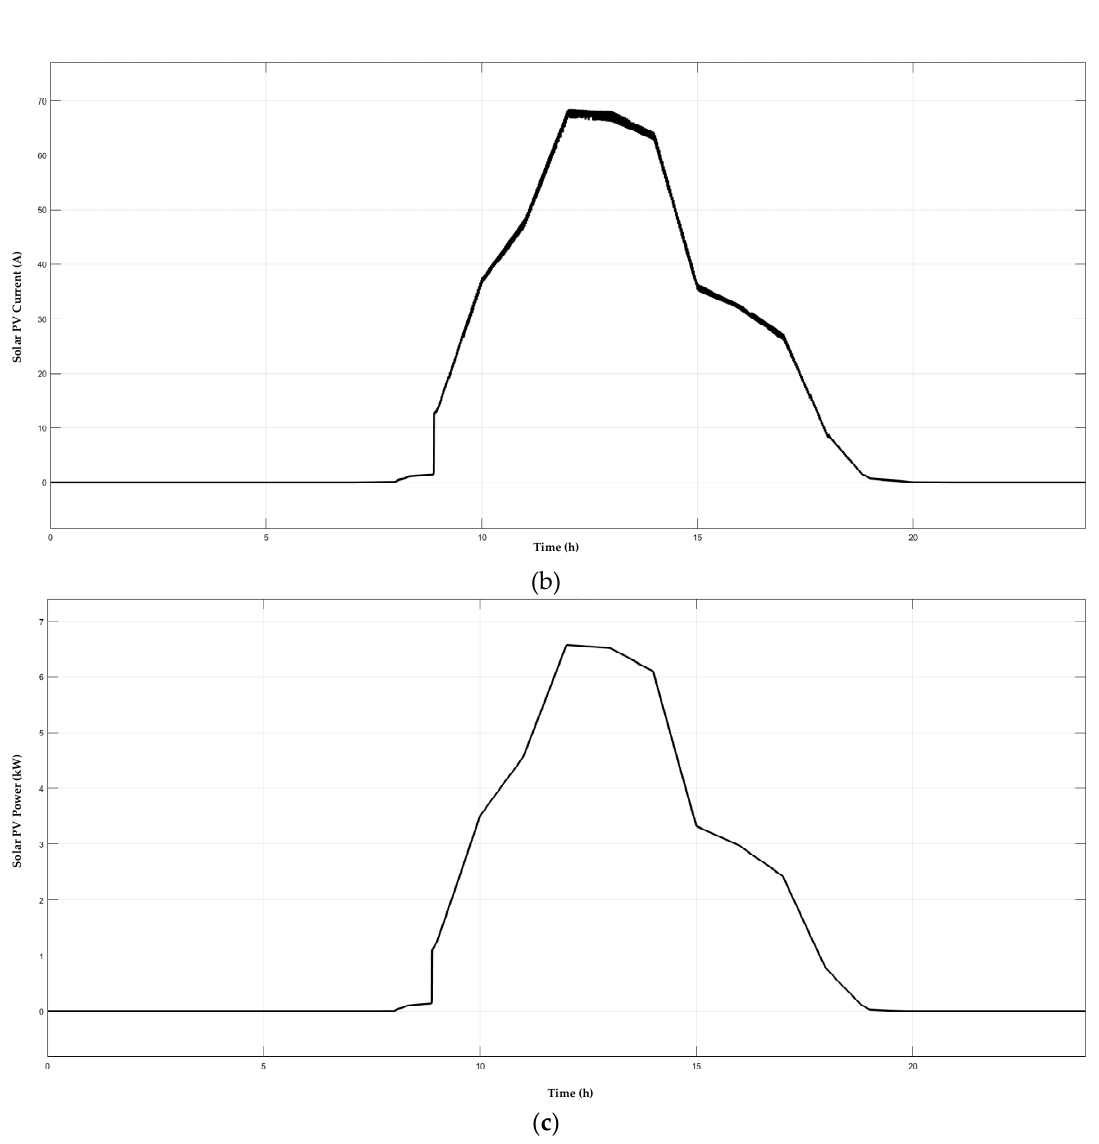
Figure 14. ( a ) Voltage characteristic curve for PV system; ( b ) current characteristic curve for PV system; ( c ) power characteristic curve for PV system.